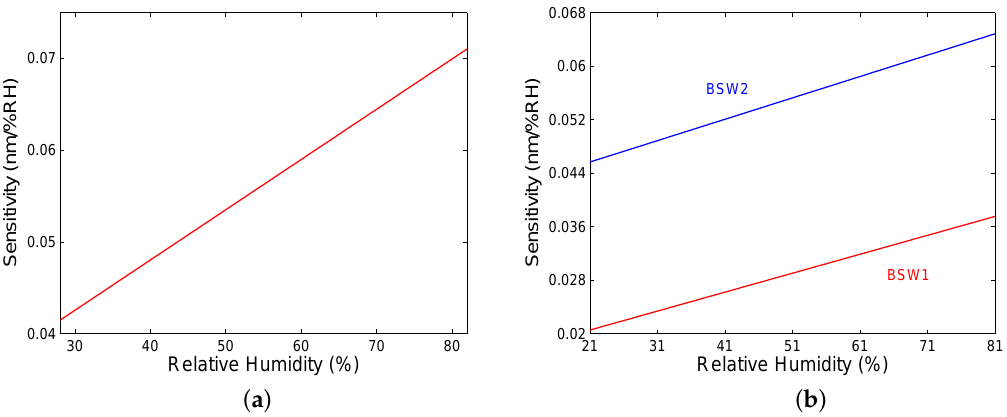
Figure 11. Sensitivity as a function of the RH of moist air for SPR ( a ), and for two BSWs ( b